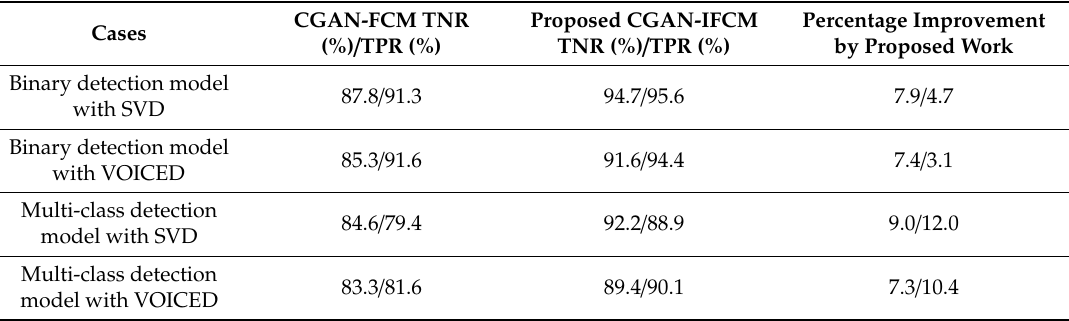
Table 7. Performance comparison between CGAN-IFCM and